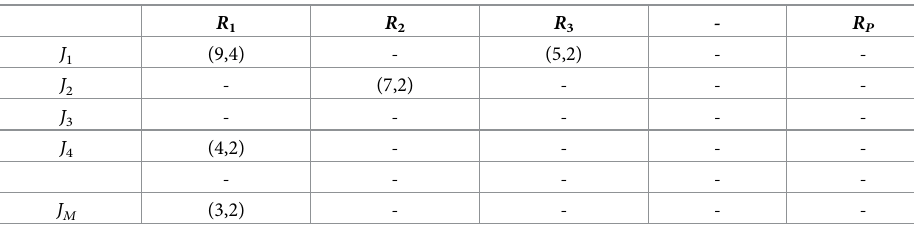
Table 1. Sample time and resource quality to execute the